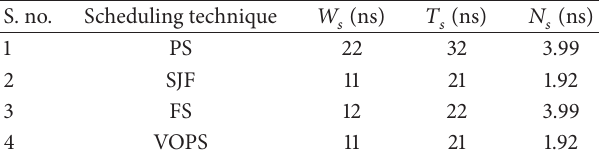
Table 3: Outcomes of Task Set 1.